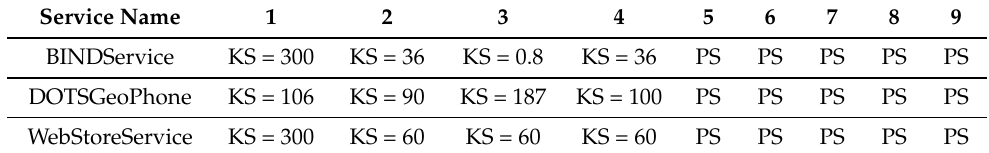
Table 6. Case study web services description of the type of recognition